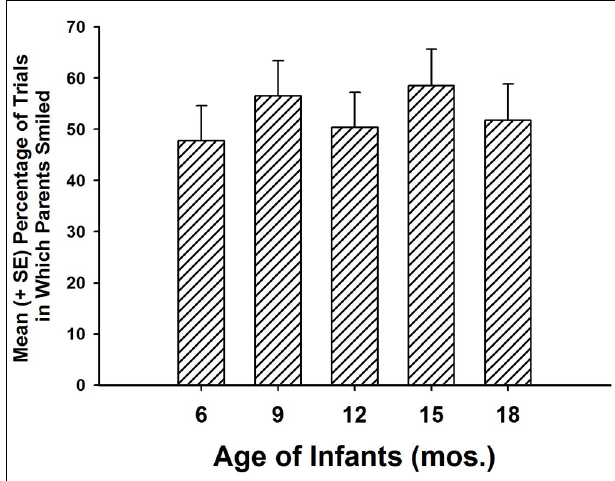
FIGURE 3 | Parents did not differ in the amount of smiling they displayed for their infants, across the entire age range of this study, with infants from 6 to 18 months of